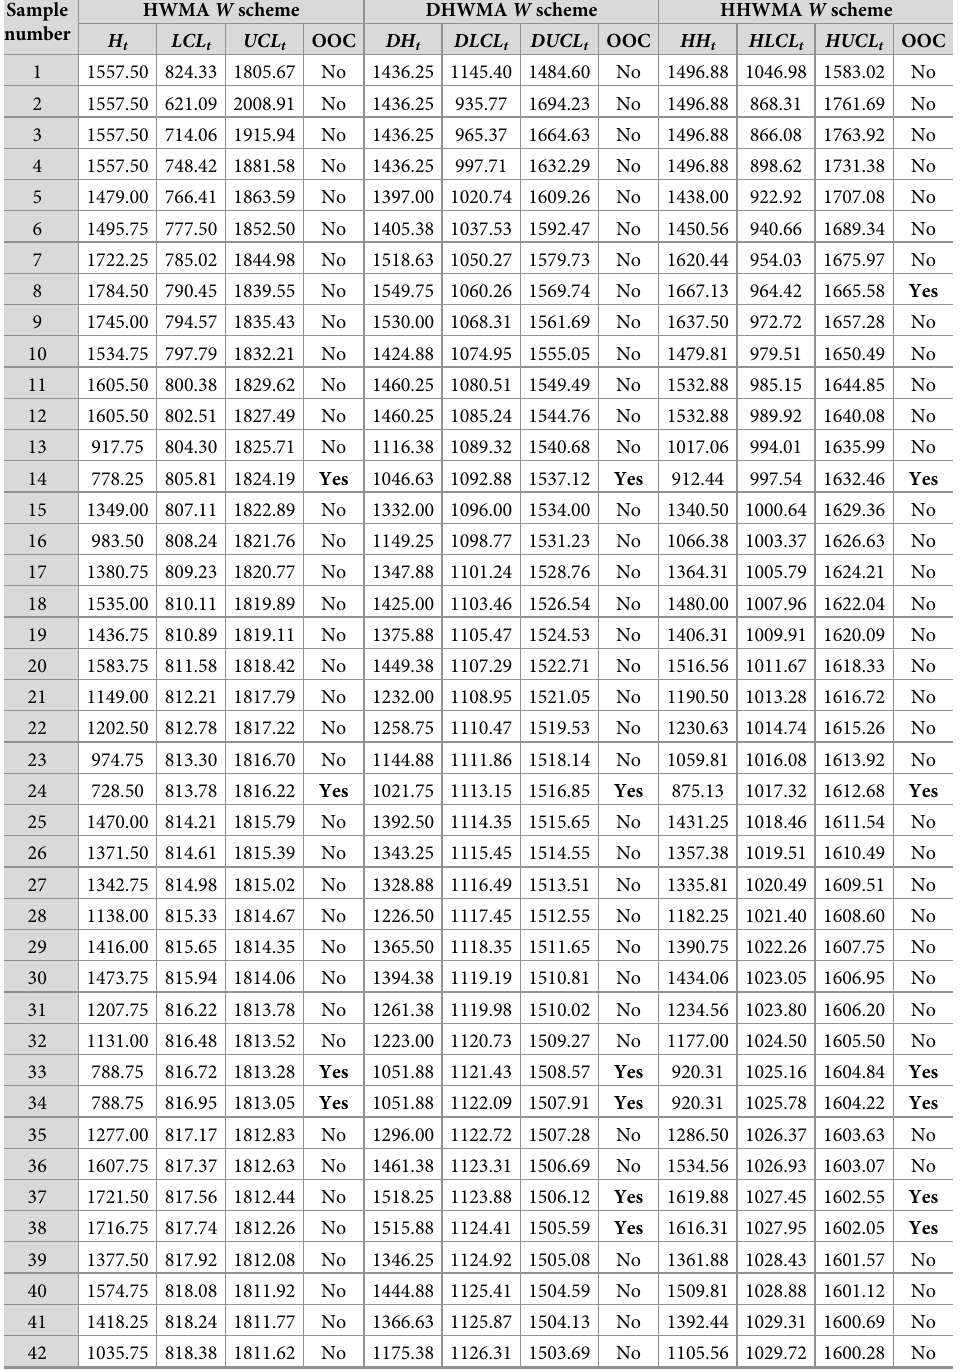
Fig 7. HWMA, DHWMA and HHWMA monitoring schemes of the iron ore date when m = 520, n = 5, λ = 0.5, λ 1 = 0.75 and λ 2 = 0.5 for and nominal ARL 0 value of 500. https://doi.org/10.1371/journal.pone.0261217.g007 Table 8. Illustration example of the proposed HWMA, DHWMA and HHWMA W charts using the mining iron ores data with ( m , n , λ , λ 1 , λ 2 ) = (520, 5, 0.5, 0.75, 0.5) for a nominal ARL 0 = 500. Sample